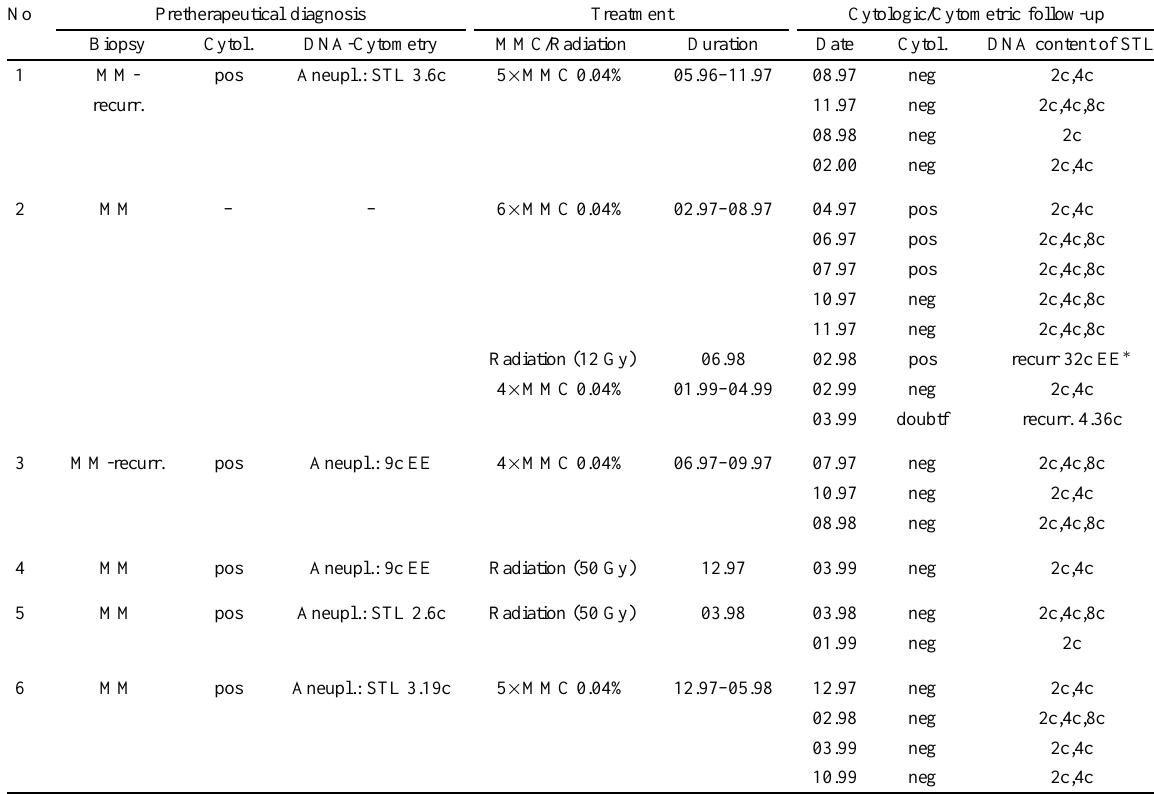
Summary of clinical data, diagnoses, treatment and follow ups of patients with conjunctival malignant melanoma No Pretherapeutical diagnosis Treatment Cytologic/Cytometric follow-up